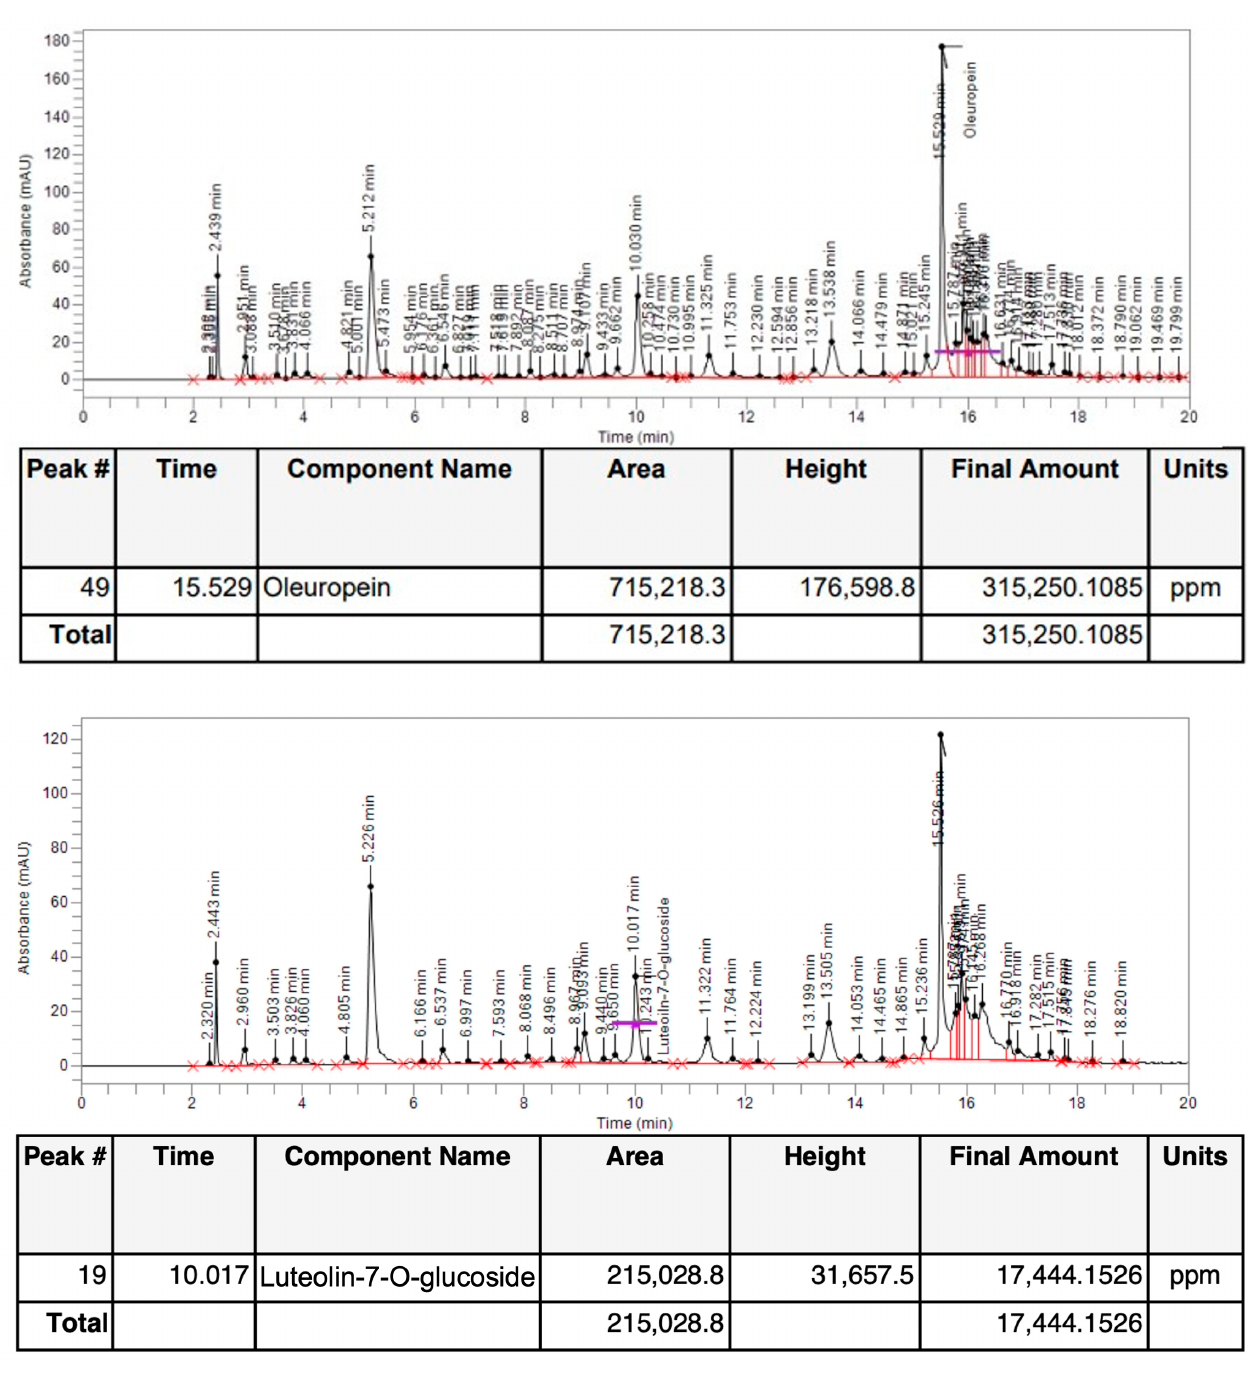
Figure 4. HPLC analysis of O. europaea L. leaf concentrated extract by resin (Nocellara del Belice